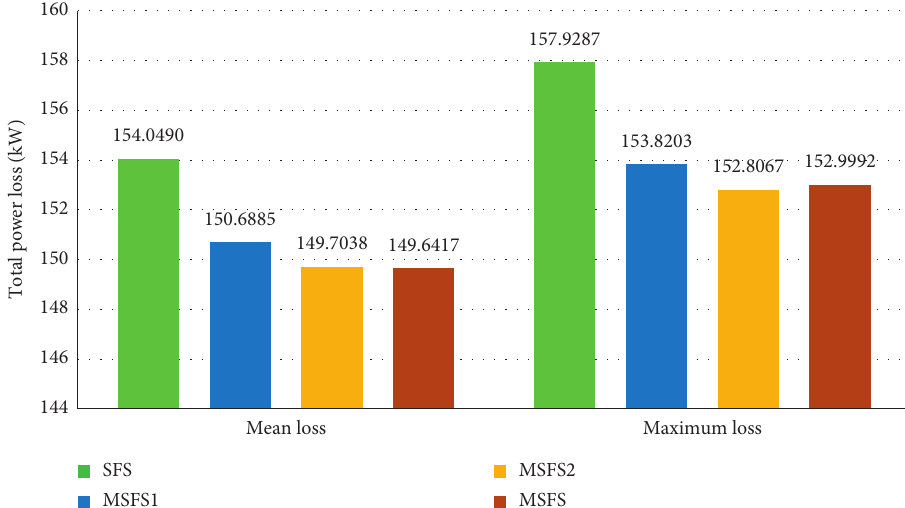
Figure 26: Mean and maximum power loss of 50 trial runs obtained by SFS methods for case 3 of the 85-bus